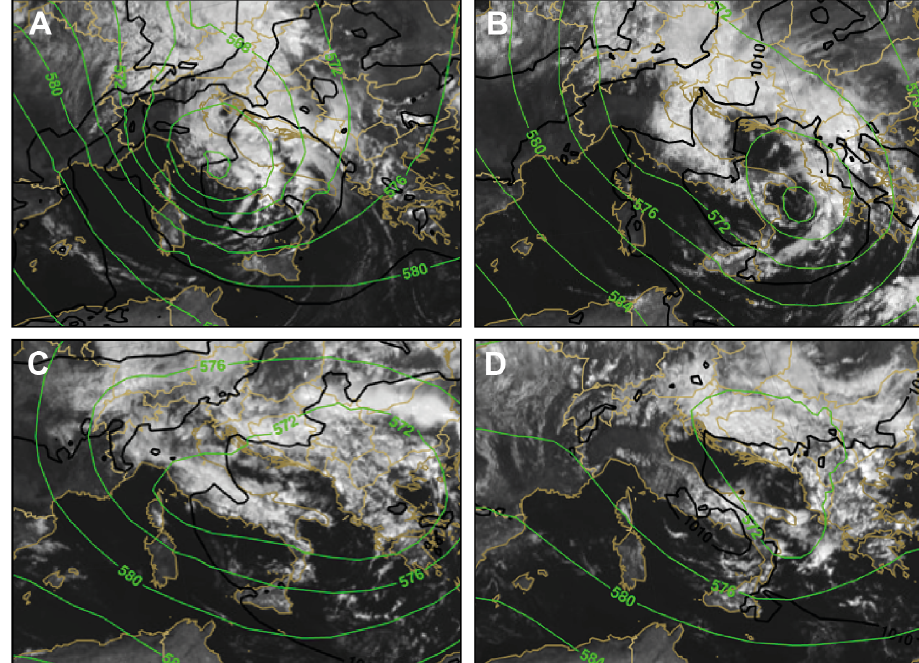
Figure 2. Meteorological setting for the period 1–6 September 2014 over central and southern Italy. Images show Meteosat Second Gen- eration (MSG) – visible (VIS) 0.6µm for (a) 1 September 2014, 12:00UTC, (b) 2 September 2014, 12:00UTC, (c) 3 September 2014, 12:00UTC, (d) 6 September 2014, 12:00UTC. Green lines show geopotential height of 500 hPa pressure level. Black lines show mean sea level pressure. Light brown lines show geographical boundaries. Source: